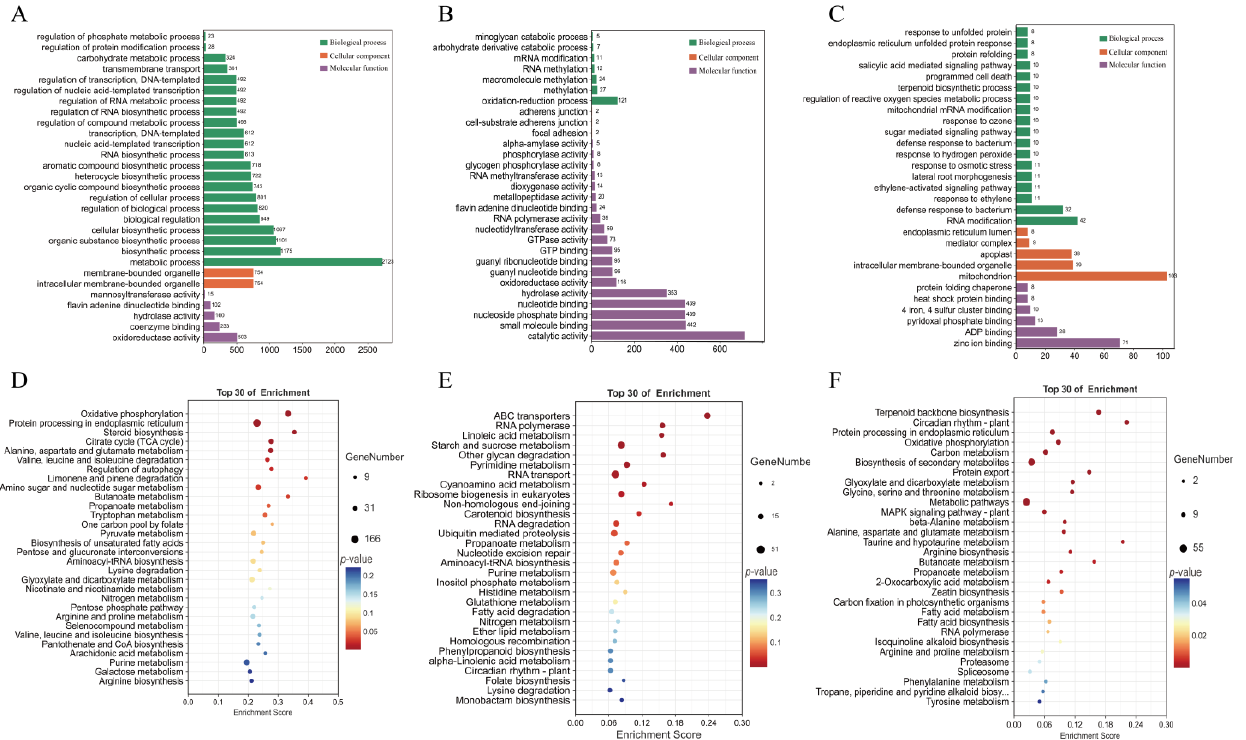
Figure 3. GO and KEGG analysis of the biological function of genes, LncRNAs, and target genes of LncRNAs. GO terms of up- ( A ) and down-regulated genes ( B ), ( C ) cis-target genes of lncRNAs, KEGG pathway enrichment analysis of genes, mRNA KEGG pathway of up- ( D ) and down-regulated mRNAs ( E ), and cis-regulated target genes of lncRNAs ( F ).